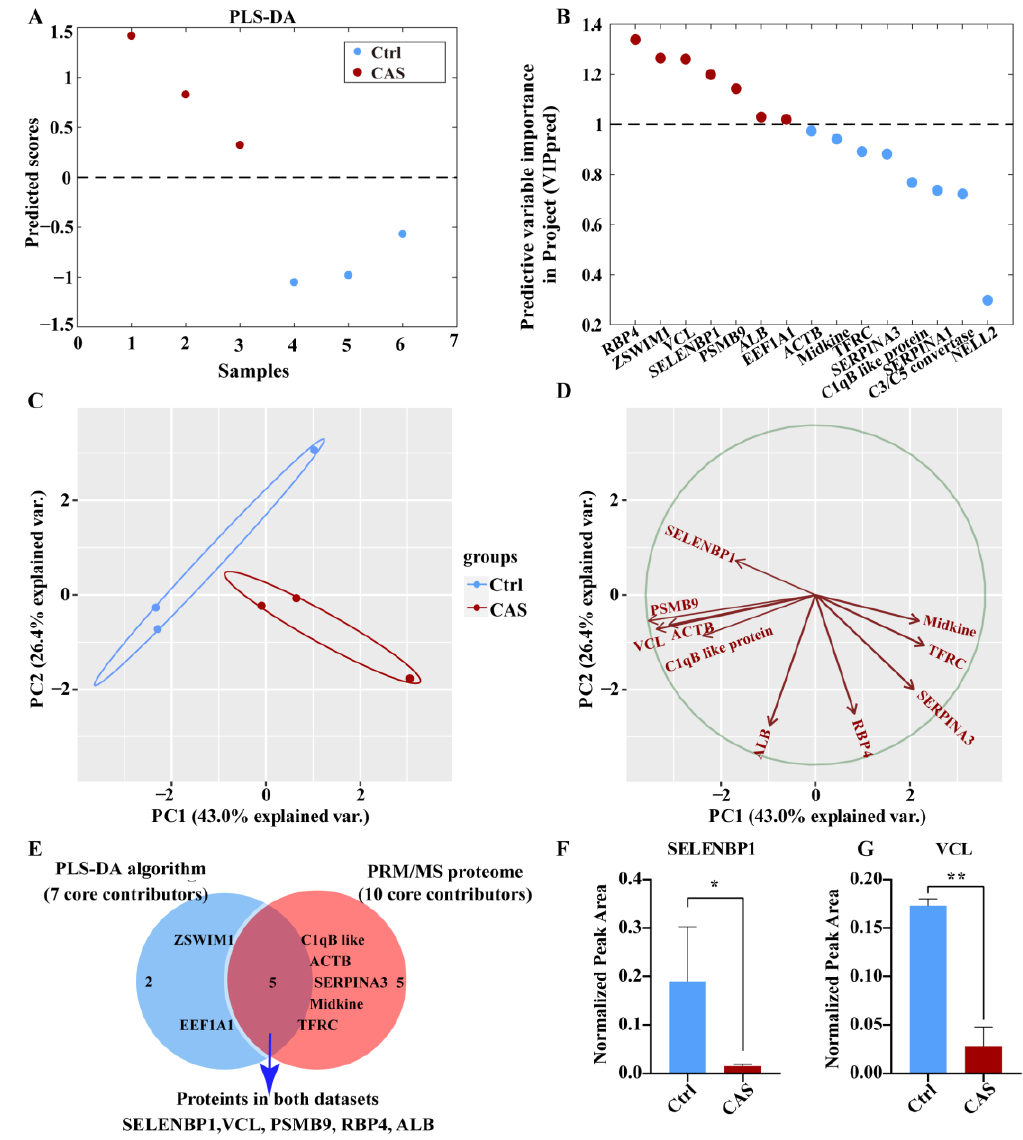
Figure 3. Parallel reaction monitoring/mass spectrometry (PRM/MS)-based targeted proteome and partial least-squares discriminant analysis (PLS-DA) validated SELENBP1 and VCL as the top dysregulated proteins. ( A ) Discrimination power of the quantified 15 candidate proteins from Ctrl to CAS analyzed by PLS-DA algorithm. ( B ) Seven candidate proteins (VIPpred > 1) were the core contributors to discrimination by predictive variable importance in projection (VIPpred) analysis (Red dots: VIPpred > 1; Blue dots: VIPpred < 1). ( C , D ) Principal component analysis (PCA) showed that the top 10 proteins could discriminate CAS from Ctrl serum. ( E ) Cross-analysis of the results from PRM/MS proteome and PLS-DA results. ( F , G ) The validated contents of SELENBP1 and VCL in CAS and Ctrl serum. *, p < 0.05; **, p < 0.01 as indicated.